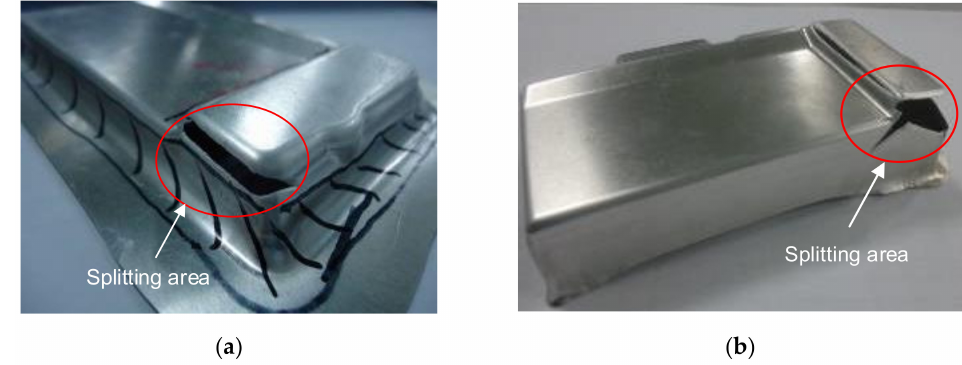
Figure 18. The experimental forming results for Case I. ( a ) The first stage; ( b ) the second stage.